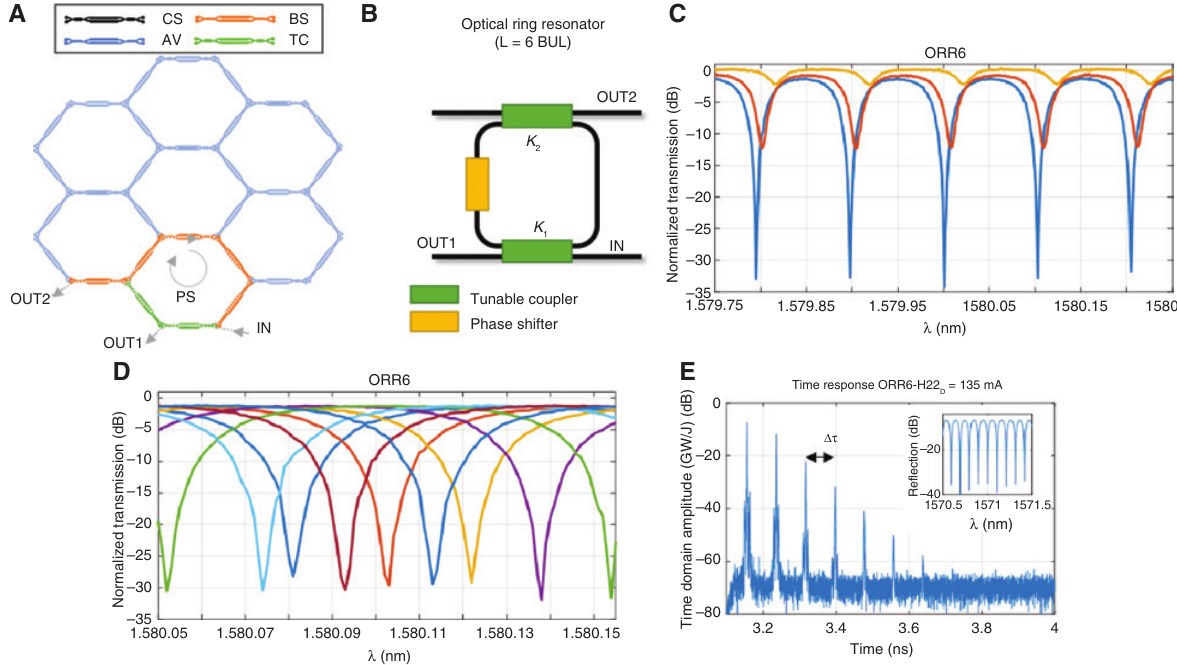
Figure 11: Experimental results for 6-BUL ring resonator IIR and FIR + IIR filters programmed over the silicon hexagonal waveguide mesh of Figure 9A. (A) Waveguide mesh connection diagram, (B) circuit layout and (C) measured modulus transfer function for an IIR filter for different values of the coupling constants K and K , (D) IIR filter along a full spectral period for different values of the optical ring resonator round-trip phase 1 2 shift and (E) time response for critical coupling